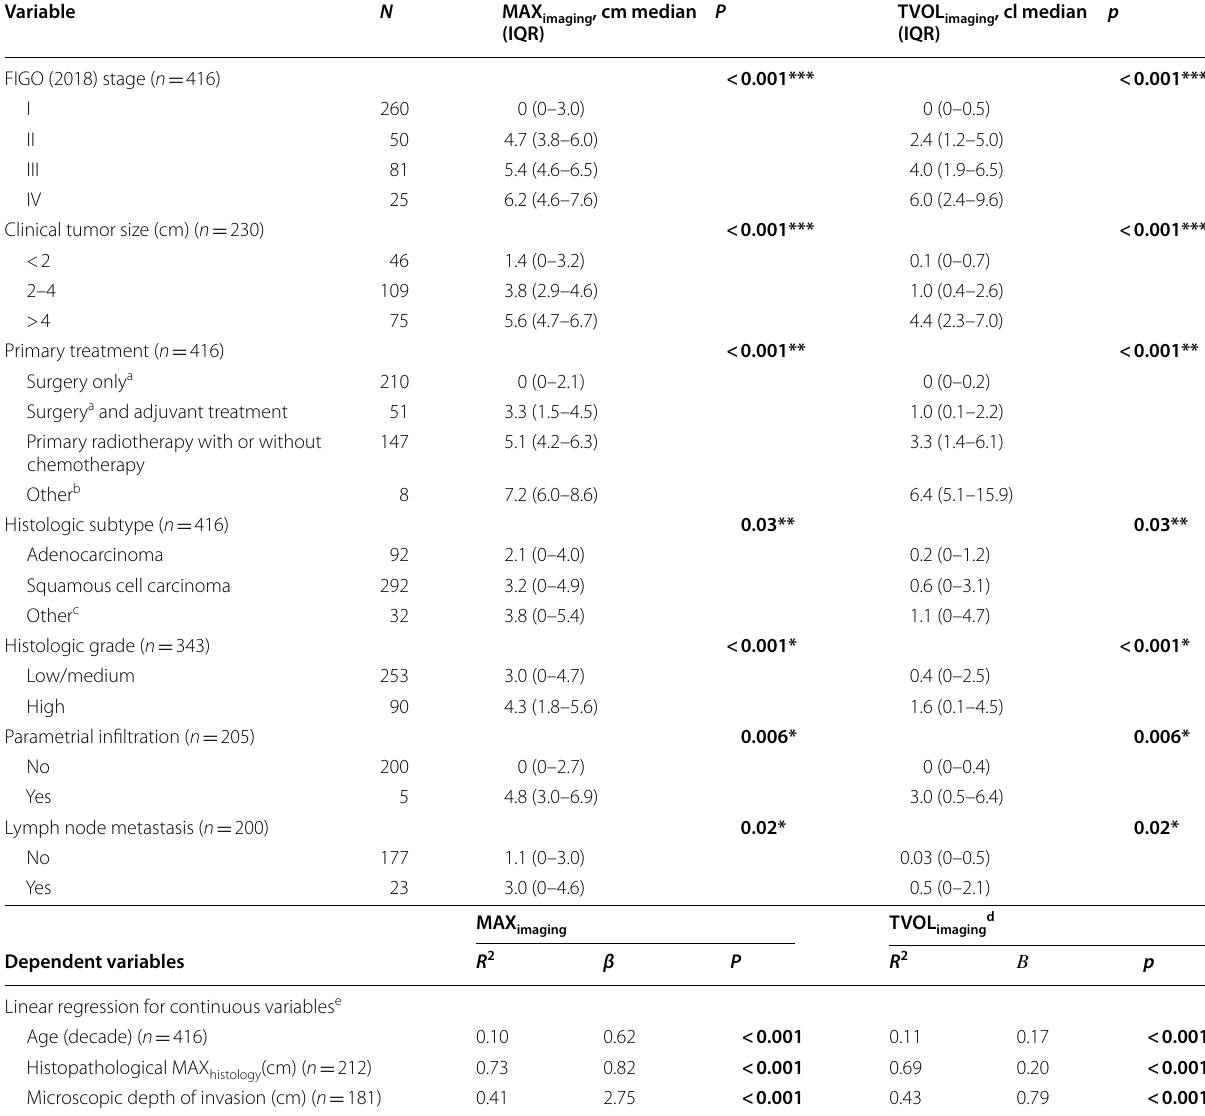
) and tumor volume (TVOL imaging